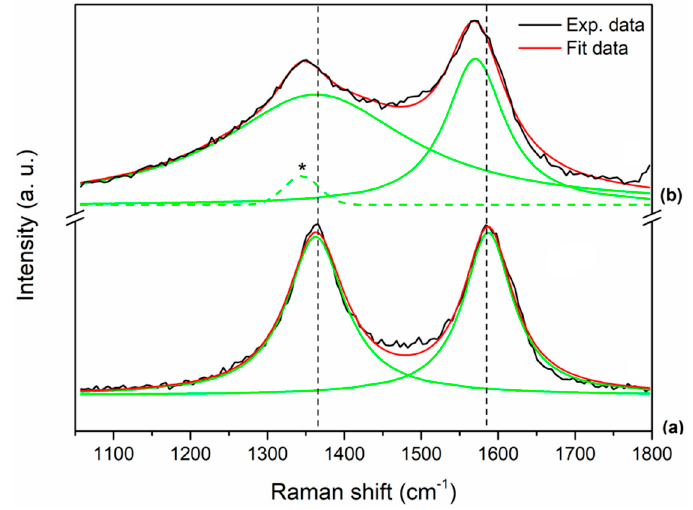
Figure 5. Raman spectra of GQD (curve a) and of the DDS GQD-PEG-BFG@Pyr-RF (curve b) samples. Lorentzian peaks (green lines) are used to reproduce the Raman